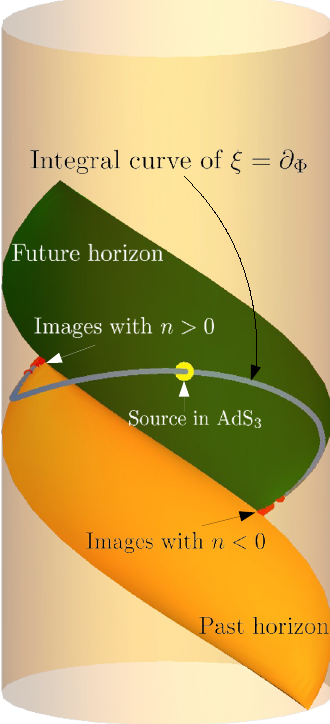
Figure 3 . Method of images for the extremal BTZ Green function. A source point (yellow) in the (cid:12)ducial portion of AdS 3 de(cid:12)nes image points (red) appearing every 2 (cid:25) along the integral curve of (cid:24) = @ (cid:8)